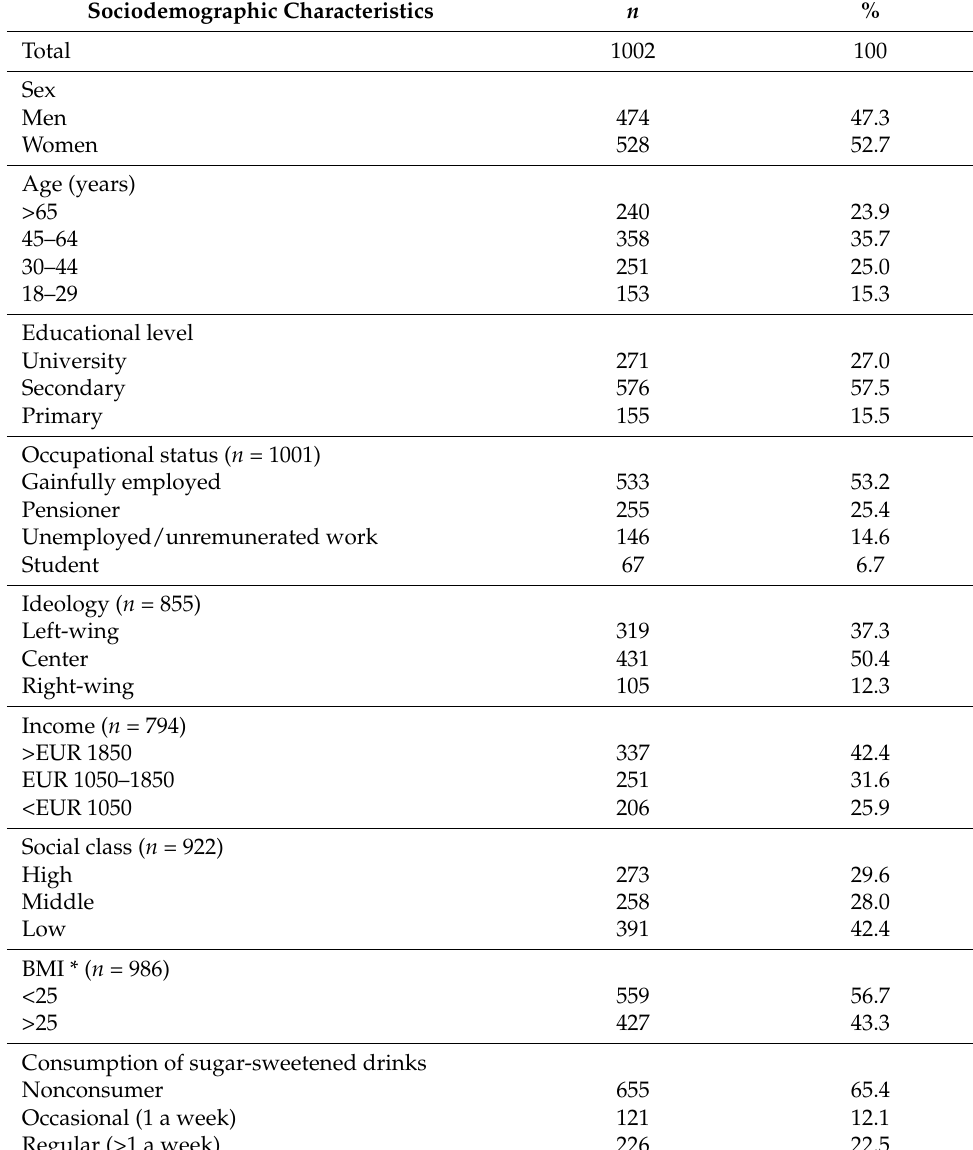
Table 1. Sociodemographic characteristics of the study sample, representative of the Spanish adult population: